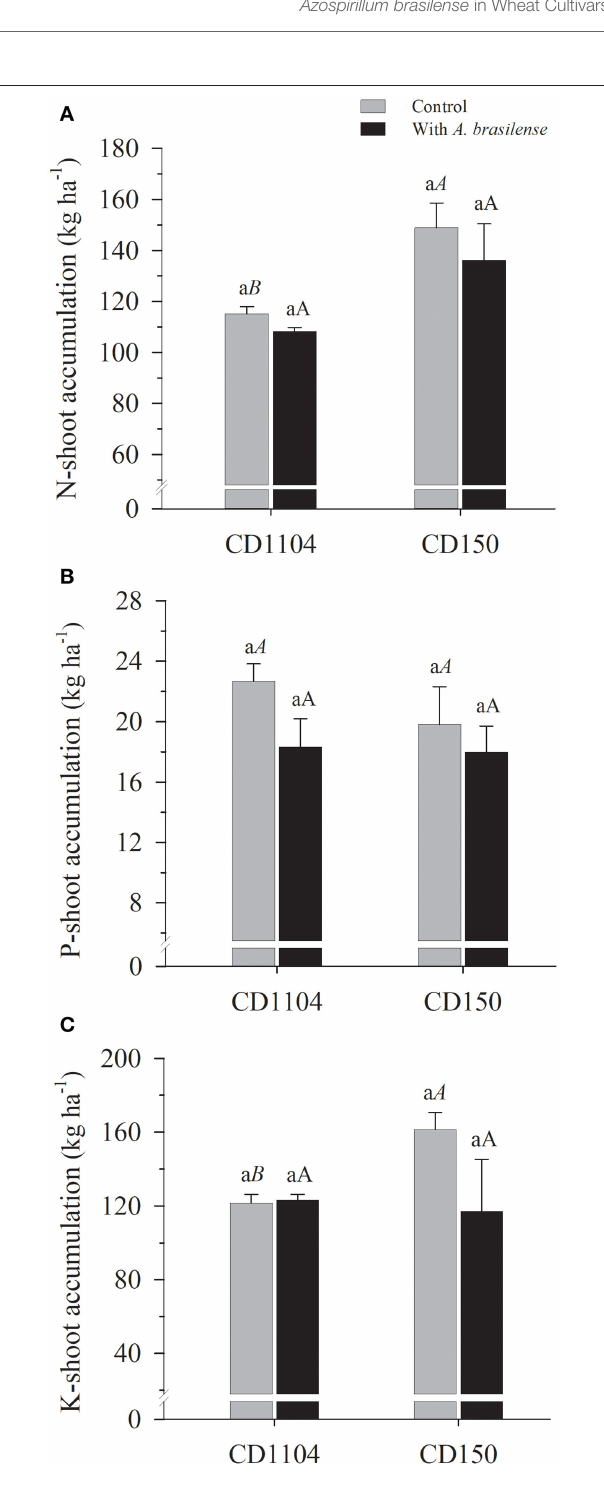
FIGURE 2 | Effects of inoculation with Azospirillum brasilense on the shoot of the wheat cultivars CD1104 and CD150 in the nutritional accumulation of N (A) , P (B) , and K (C) . Different letters indicate difference between means according to a Tukey test ( p ≤ 0.05). Lowercase letters correspond to cultivars within each inoculation level, and uppercase letters correspond to inoculations within each cultivar level. Identical letters do not differ from each other according to a Tukey test ( p ≤ 0.05). CV (%) = 17.9 (A) , 16.2 (B) , and 18.8 (C) . Error bars indicate the standard error of the mean ( n = 6